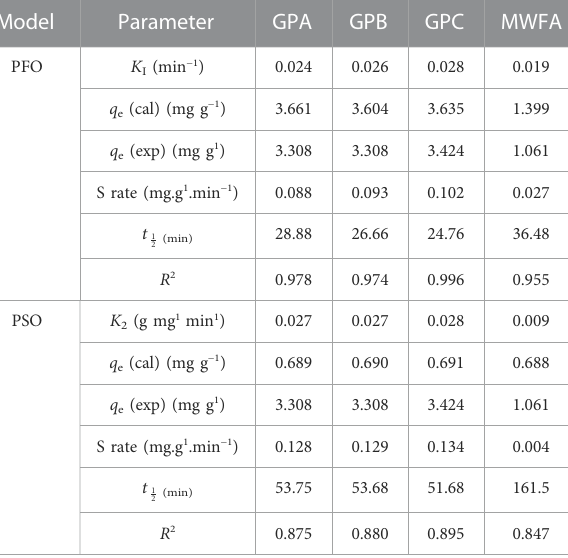
TABLE 2 Lagergren pseudo - fi rst-order (PFO) and pseudo -second-order (PSO)